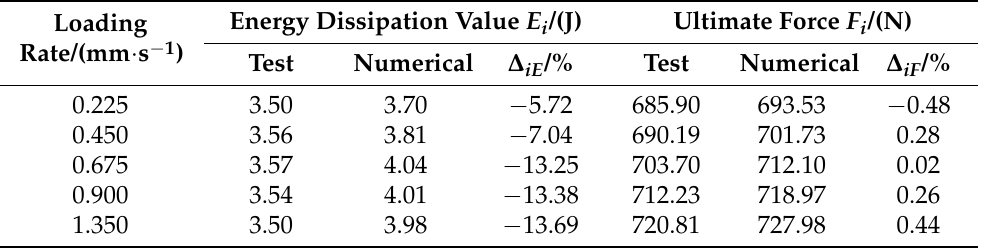
Table 4. Comparison of results under different loading